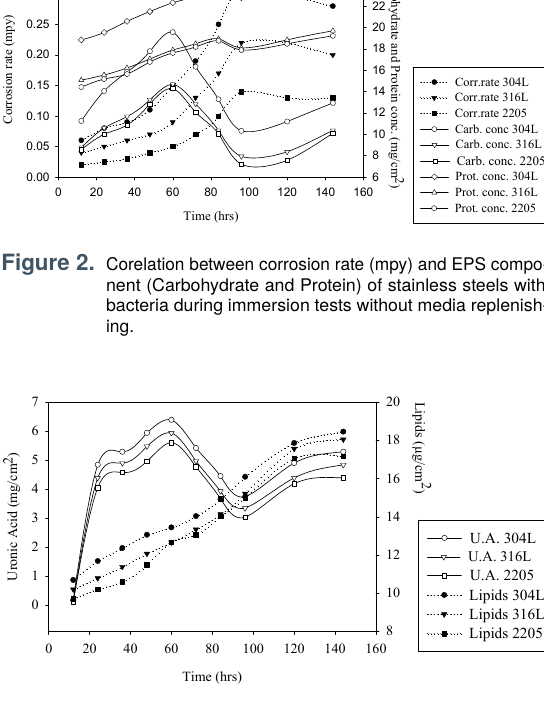
replenishingTime Fig. 4 Corelation between corrosion rate (mpy) and EPS components (carb., protein and U.acid) of 304L with bacteria during immersion tests without media